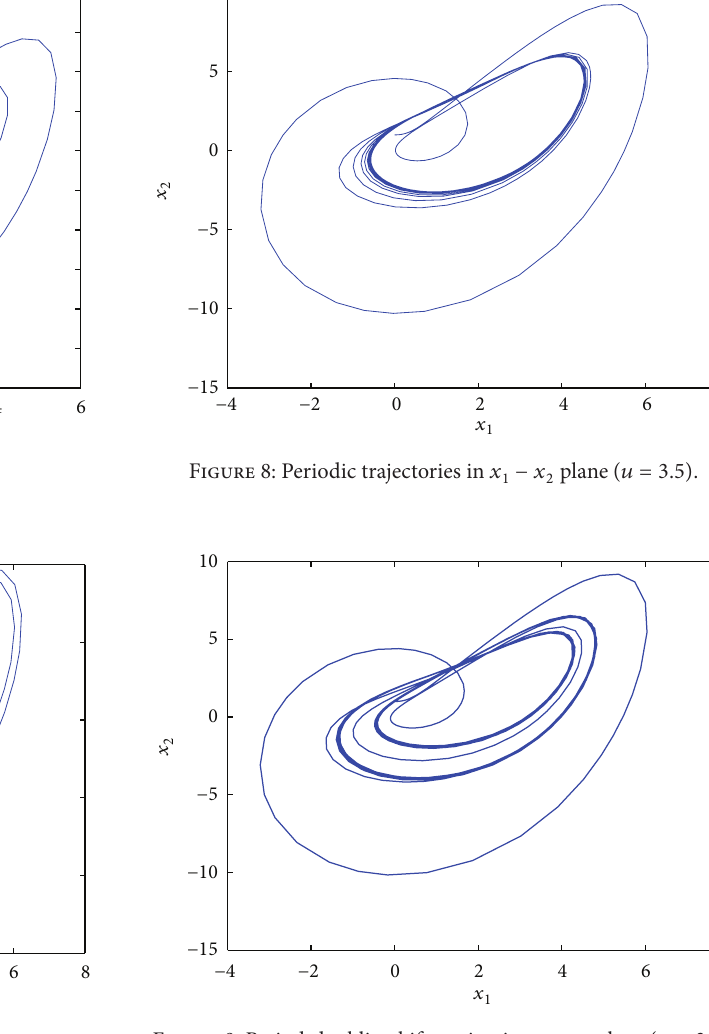
Figure 6: Right half attractor (𝑢 = 2.9) .